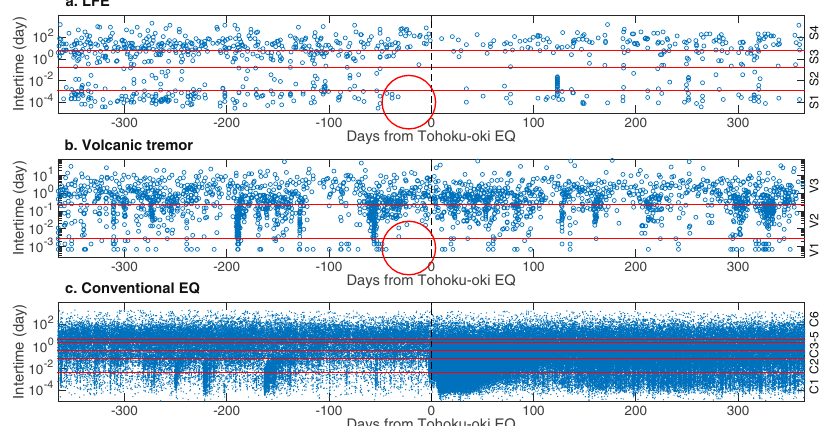
Figure 4. Raw data showing occurrence of neighboring events one year before and after the Tohoku-oki EQ. Panel a: LFE. Each point denotes the pre-event of a pair of LFEs for a given inter-time. The horizontal axis denotes days from the Tohoku-oki EQ while the vertical axis denotes inter-time. The red lines indicate borders between classes. LFEs of class S1 ceased before the Tohoku-oki EQ (red circle). Panels b and c: the same plots for volcanic tremors and conventional